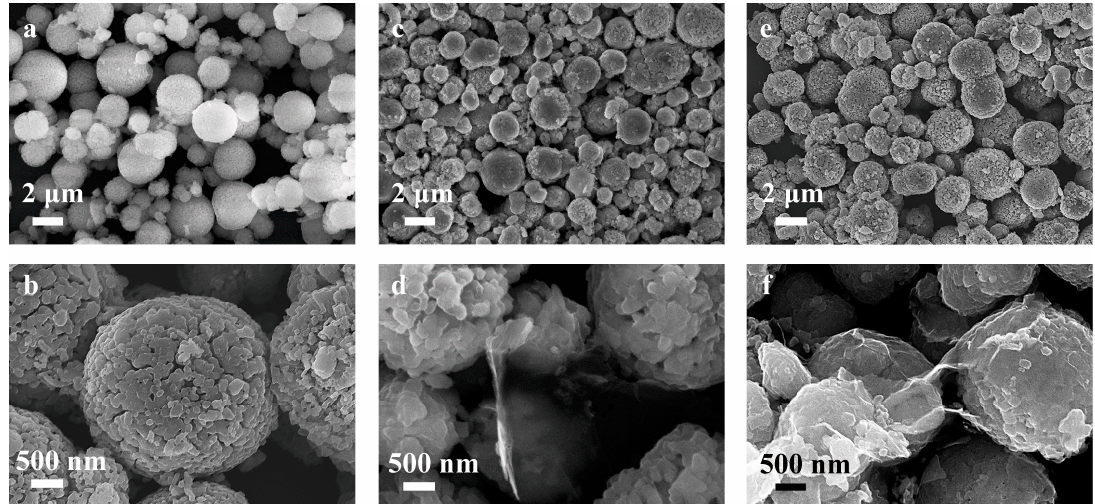
Figure 4. Images of ( a ), ( b ) pristine LLO powders, ( c ), ( d ) rGO-coated LLO powders without the use of the surfactant and ( e ), ( f ) the LLO@rGO powders. The weight ratio of rGO to LLO is 0.5%.